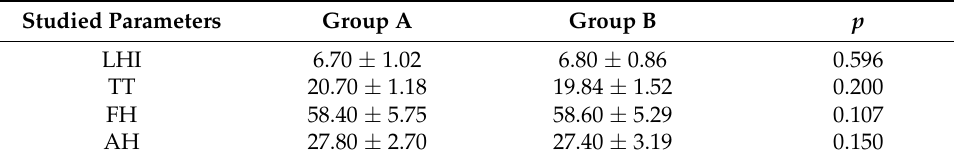
Table 2. The initial values of parameters in the two